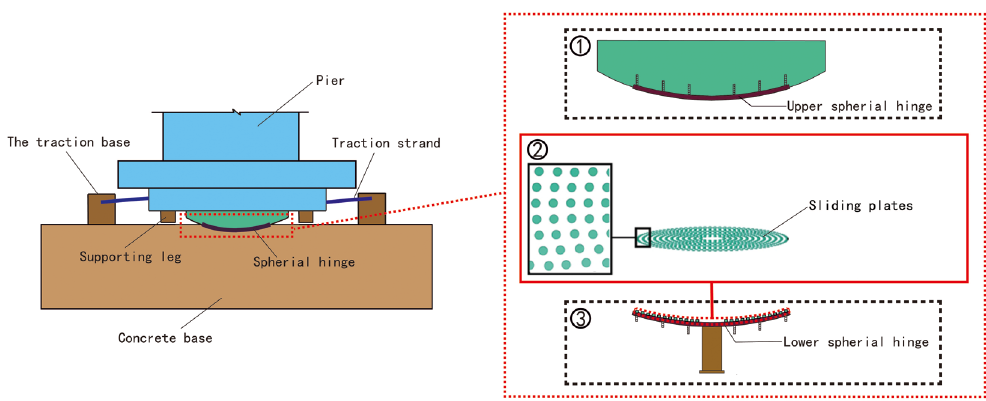
Note: the base is fixed during the Figure 2. Configuration of the rotating mechanism